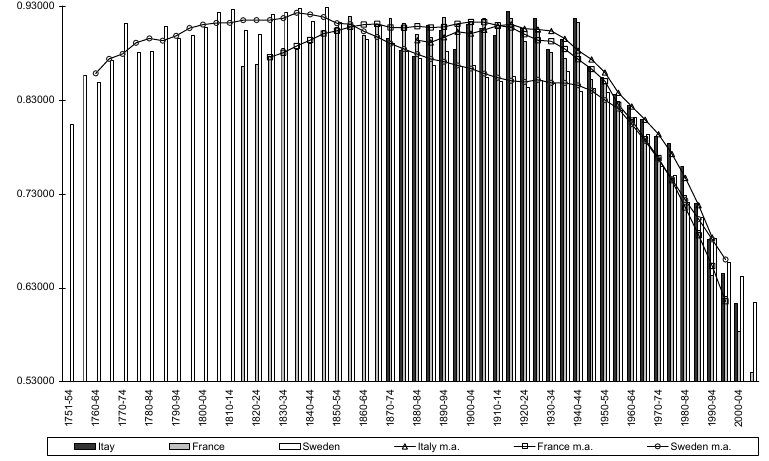
Figure 1 – Probability of dying between 80 and 90 years of age in Sweden (1751-2007), France (1816-2004) and Italy (1872-2004)